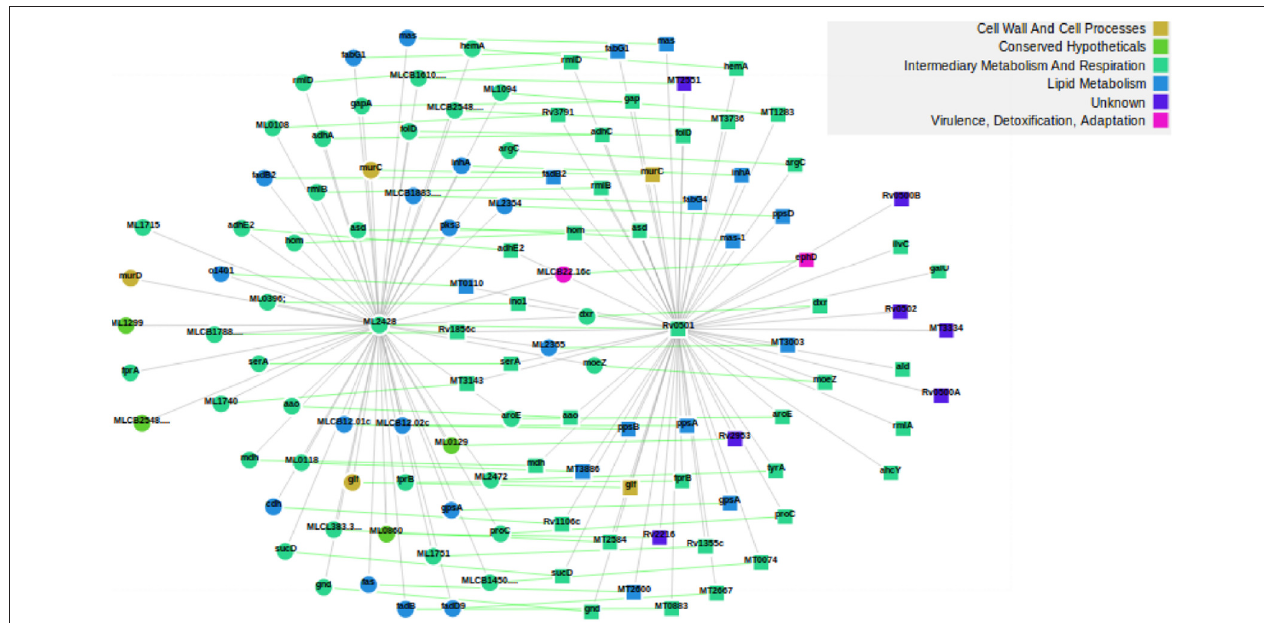
FIGURE 2 | The two proteins Q9CB57/ML2428 in MLP (left) and P0A5D1/Rv0501 (right) in MTB, and their respective 58 and 62 neighbors. As shown by the green lines, 53 proteins are direct ortholog neighbors in both. In this example, we used the ortholog network.